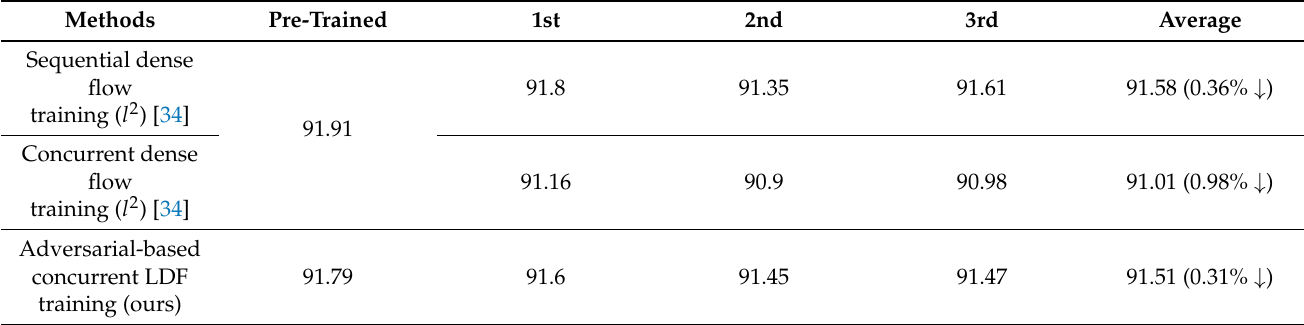
Table 3. Accuracy (%) of CIFAR-10 for the 26-layer pre-trained and 14-layer target ResNets. Methods